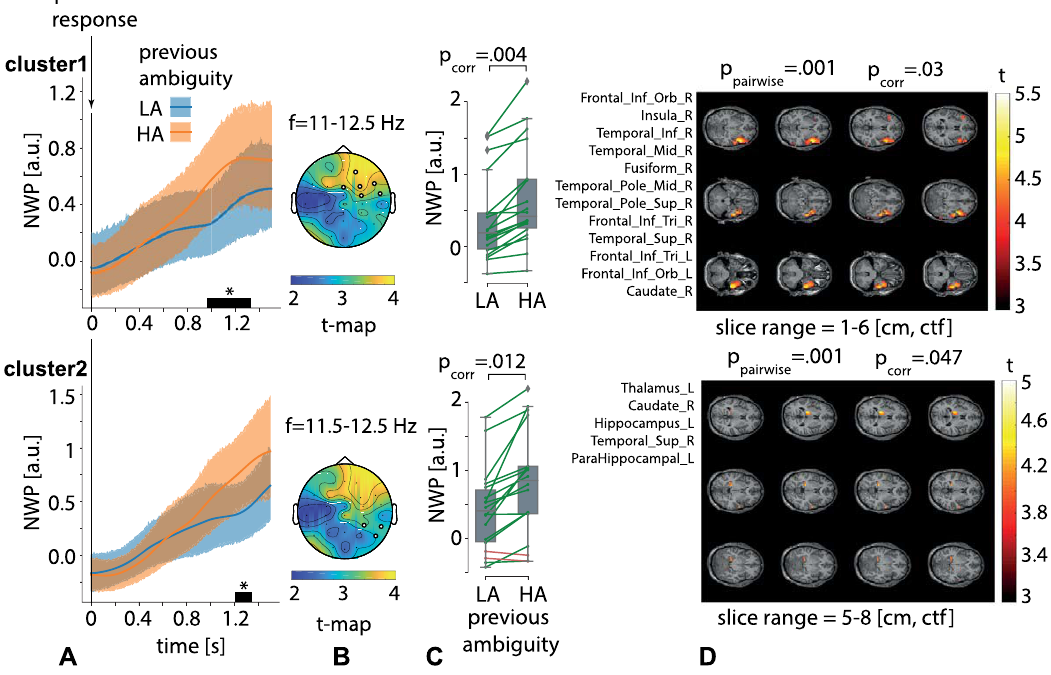
Figure 6. Two significant clusters as the result of NWP comparison after responding to HA and LA stimuli on the 1.5-s interval time-locked to the behavioral response (vertical solid line). The orange and blue curves ( A ) show the NWP evolution (group means and 95% CI) in these clusters after responding to LA and HA stimuli. The topogram ( B ) reflects the t -value and the channels demonstrating a significant change of NWP between analyzed conditions on the EEG sensor level. The box-plot ( C ) illustrates NWP in this cluster averaged over the time interval, frequency band, and channels. The slice-plot ( D ) reflects the t -value for the voxels included in the source-level cluster. p corr is corrected for multiple comparisons via the cluster-based test with the Monte-Carlo randomization p = .004 appeared from 1.0 to 1.33 s after the behavioral response in the frequency-range of 11–12.5 Hz (Fig. 6A, top plot). It included EEG sensors {Fz, Fp2, F4, F8, FC4, FT8} in the right-lateralized frontal EEG rows (Fig. 6B, top plot). The averaged NWP in this cluster was higher after responding to the HA stimulus in all subjects (Fig. 6C, top plot). We observed a significant positive cluster ( p = .03 ) on the source-level in this time-frequency range, including the bilateral frontal gyri, right temporal gyri, right insula, fusiform gyrus, and caudate nucleus (Fig. 6D, top plot). The second sensor-level cluster with p = .012 appeared from 1.0 to 1.1 s after the behavioral response in the frequency range of 11.5–12.5 Hz (Fig. 6A, bottom plot). It included EEG sensors {P8, CP4, TP8} in the right-lateralized temporal EEG rows (Fig. 6B, bottom plot). The averaged NWP in this cluster was higher after processing HA stimulus in 16 subjects (Fig. 6C, bottom plot). On the source level, it corresponded to a positive cluster with p = .047 , including the left parts of the thalamus, hippocampus, and the parahippocampal gyrus, as well as the right superior temporal gyrus, and right caudate nucleus (Fig. 6D, bottom plot). Second, we contrasted neural activity during the right-oriented LA stimulus processing, following the right- and left-oriented stimuli. Contrasting the NWP on TOI1 we found no significant clusters. Contrasting the NWP on TOI2, we found one significant positive cluster with p = .048 . This sensor-level clus- ter appeared from .49 to .37 s before the behavioral response in the frequency range of 10.25–10.5 Hz (Fig. 7A). It included EEG sensors {C3, FT7, FC3} in the left-lateralized central, temporal and frontal EEG rows (Fig. 7B). The averaged NWP in this cluster was higher when the right-oriented LA stimulus followed the right-oriented stimuli in 16 subjects (Fig. 7C). For the time-frequency range of this cluster, we calculated source power and contrasted it between the conditions. Setting the p pairwise = .001 , we did not found the source-level clusters. For the p pairwise = .01 we obtained a positive cluster with p = .172 (Fig. 7D). This source-level cluster included the left inferior frontal gyrus, left calcarine sulcus, and the left precuneus. These source-level results showed potentially interesting tendencies without being supported by the cluster-level statistics. To quantify the change of source power in these zones, we computed Cohen’s d and counted the number of subjects demonstrating the effect. As a result, we found a medium effect for the left inferior frontal gyrus ( d = 0.55 , 14 subjects), the left precuneus ( d = 0.49 , 15 subjects) and the left calcarine sulcus ( d = 0.52 , 15 subjects). Contrasting NWP on TOI3, we found one significant positive cluster with p = .034 in the frequency range of 11.5–14.5 Hz on the time interval of 1.3–1.5 s after the behavioral response (Fig. 8A). It included EEG sen- sors {Pz, P4, CPz, CP4, Cz, C4} in the right-lateralized occipito-parietal and central EEG rows (Fig. 8B). The averaged NWP in this cluster was higher after responding to the right-oriented stimulus in 15 subjects (Fig. 8C). On the source level, it corresponded to the significant positive cluster with p = .037 , including left and right